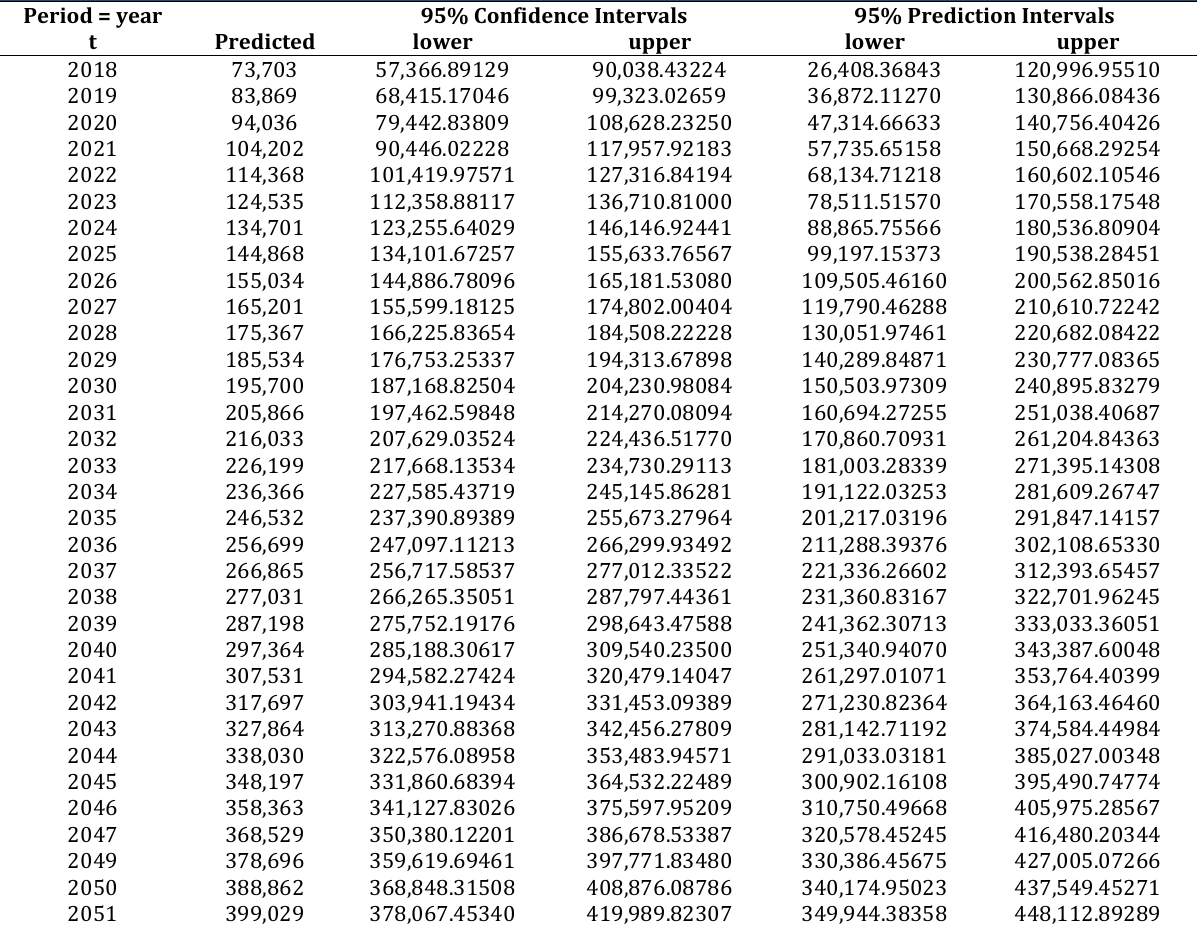
Table 5: Predicted values for Imported Container (TEU) for the net forty (40) years Period = year 95% Confidence Intervals 95% Prediction